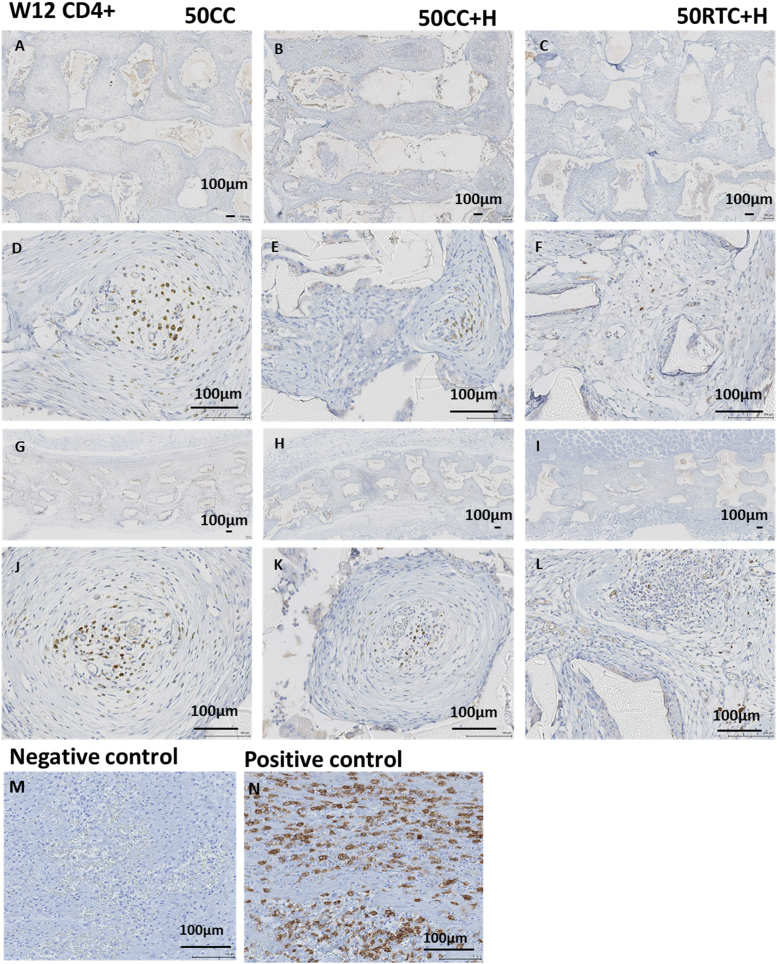
Immunohistochemistry of the host T lymphocyte response towards scaffolds in vivo at week 12. Tissue integration of middle-in-plane (A-F) and cross-sectional view (G-L) of the scaffolds by CD4 (T lymphocyte marker) staining at (A-C, G-I) ×4 and (D-F, J-L) ×20 magnifications. (M) Negative control (rat appendix); (N) positive control (rat spleen). Scale bar: 100 μm.